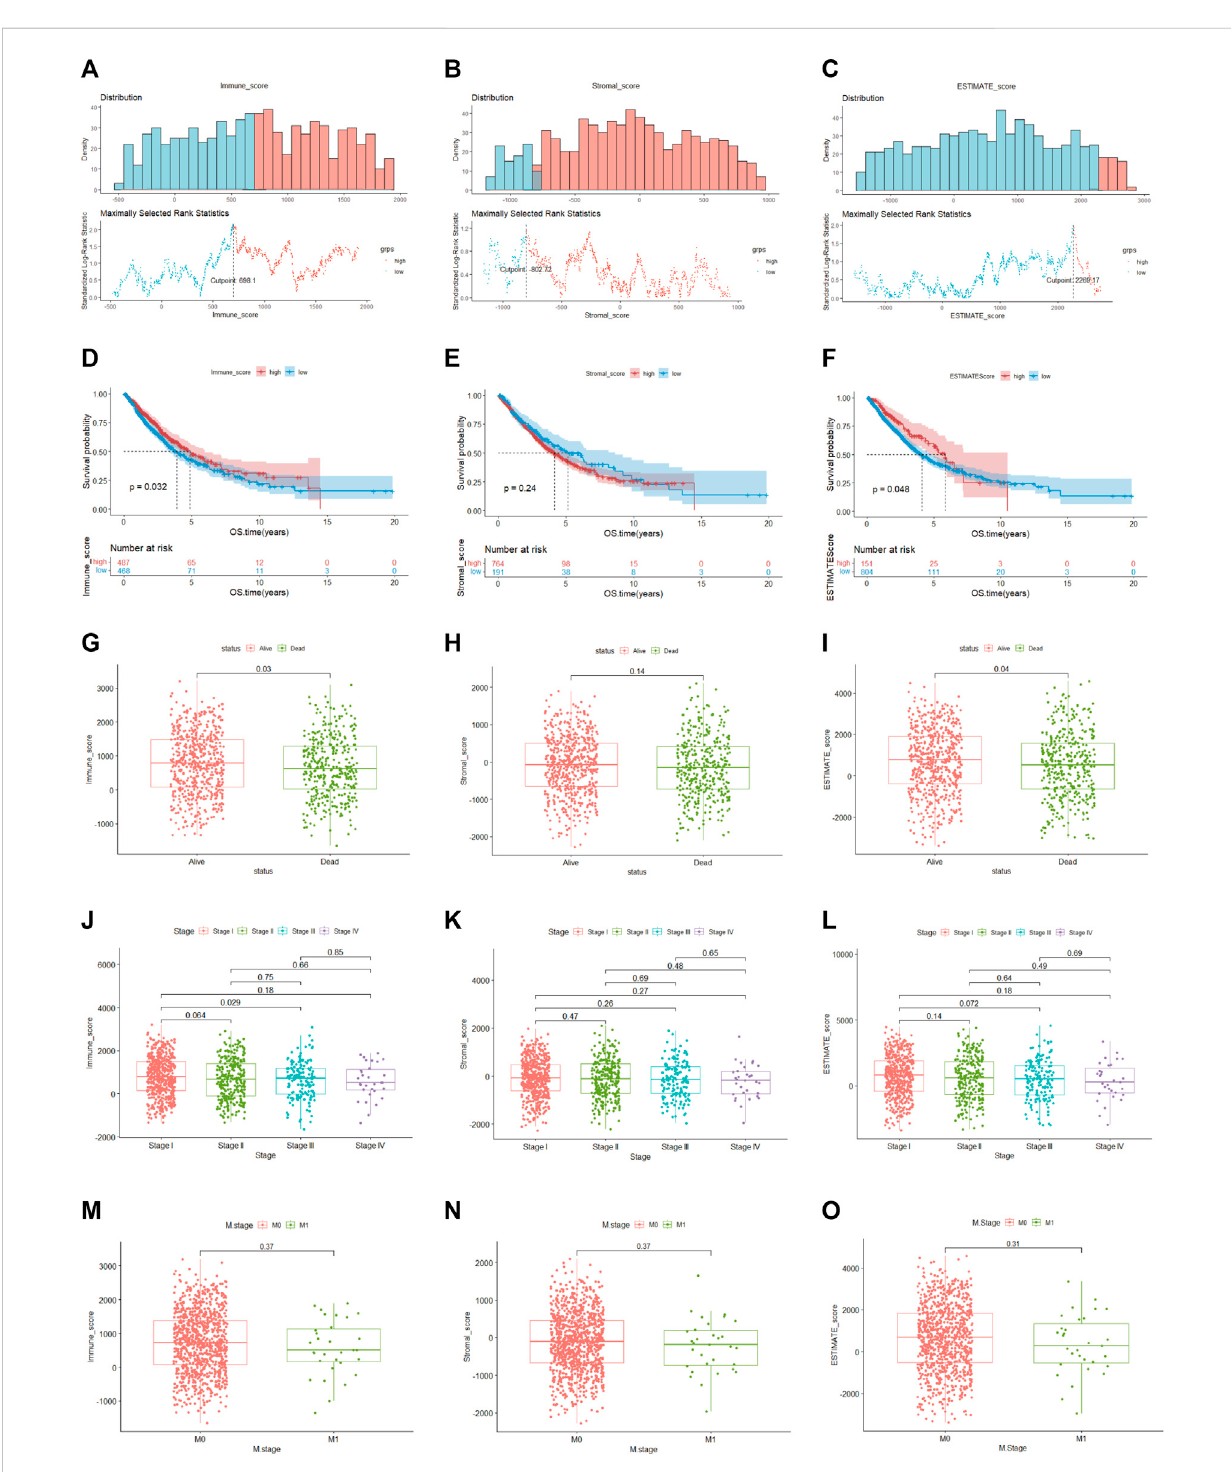
FIGURE 2 Relationship between clinical characteristics and immune, stromal and ESTIMATE scores (A – C) . The optimal cutoff values of the immune, stromal and ESTIMATE scores. (D – F) . (K – M) analysis of immune, stromal and ESTIMATE scores. (G – I) . Distribution of the three scores among patients with different statuses (J – L) . Distribution of immune, stromal and ESTIMATE scores among NSCLC stages (M – O) . Distribution of three scores between M-stage of